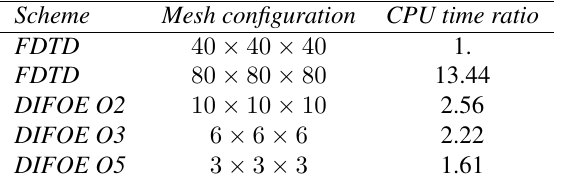
Table 1: CPU time ratio for FDTD and our method on various mesh and order configurations.